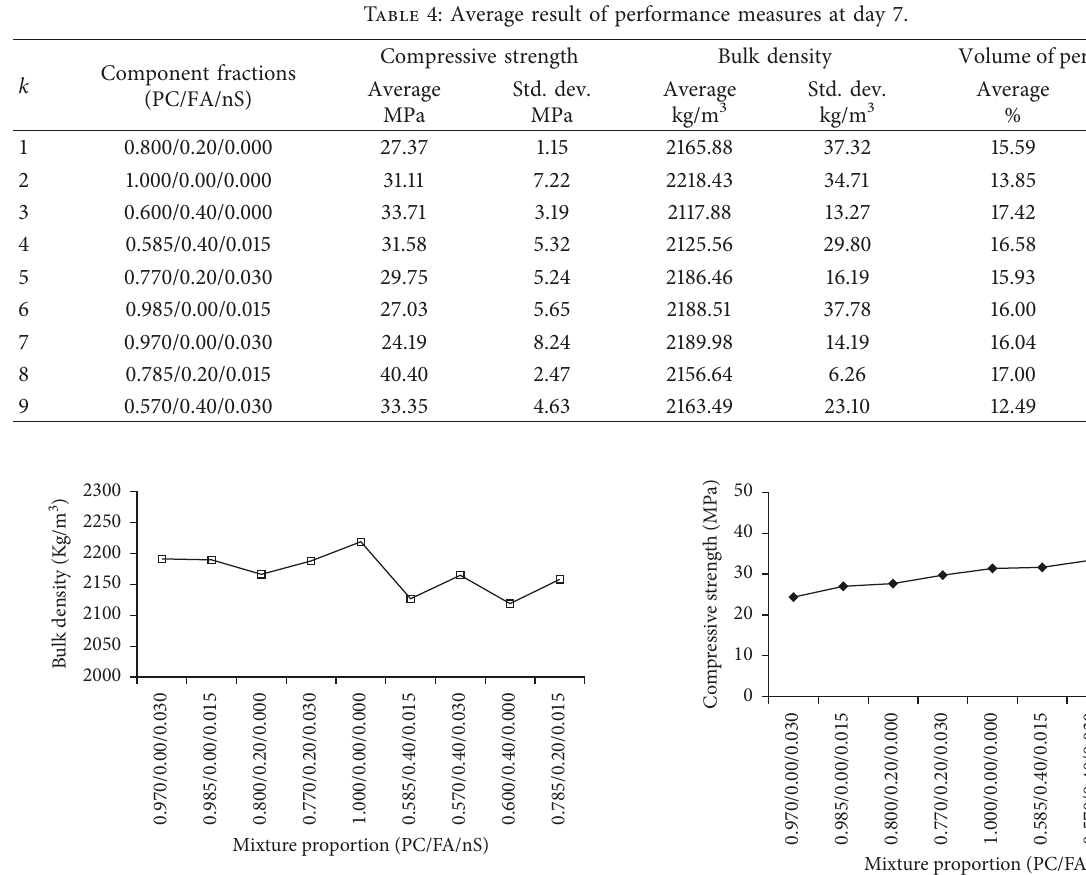
Figure 1: Mean bulk density measured at aging day 7.